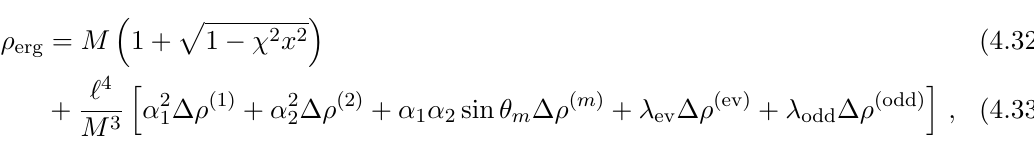
. Bottom row: 3D embedding of odd (cid:21) odd = 0 : 6 (right). In both cases, M 4